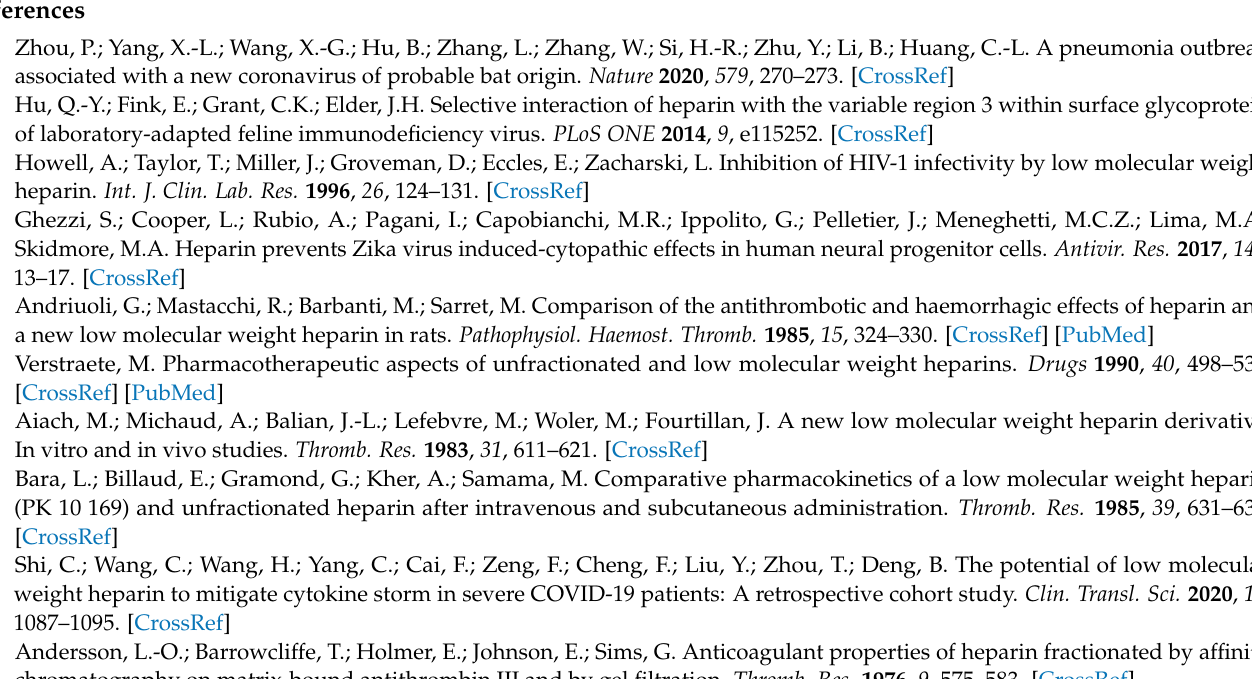
Figure S4: Human coagulation factor X (hFX) competition assays and receptor usage of HAdV of treatment with MgCl 2 -modified heparin, Table S1: Experimental and calculated 3 J HH couplings of the iduronic acid residue of heparin, Supplementary Materials and